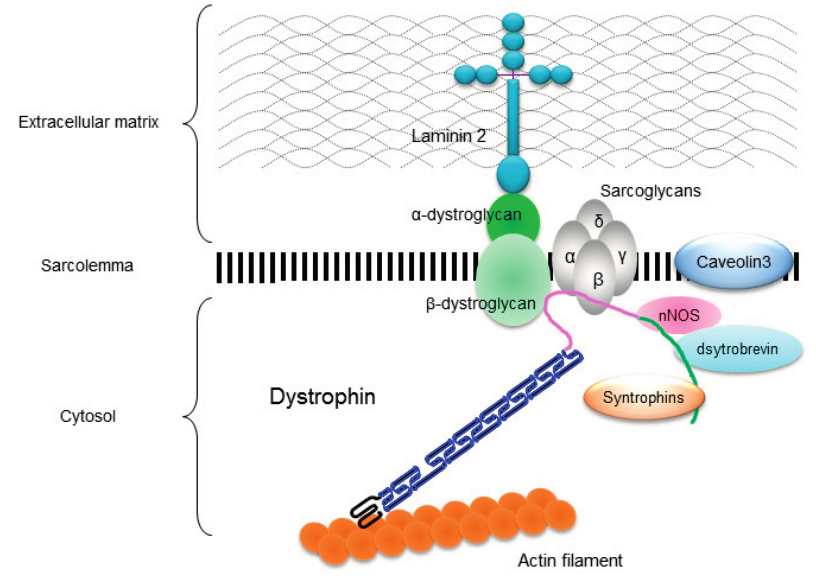
Figure 2. Localization of dystrophin and dystrophin-glycoprotein complex (DGC) in a skeletal muscle cell. Dystrophin links to actin filament at actin-binding domain, and